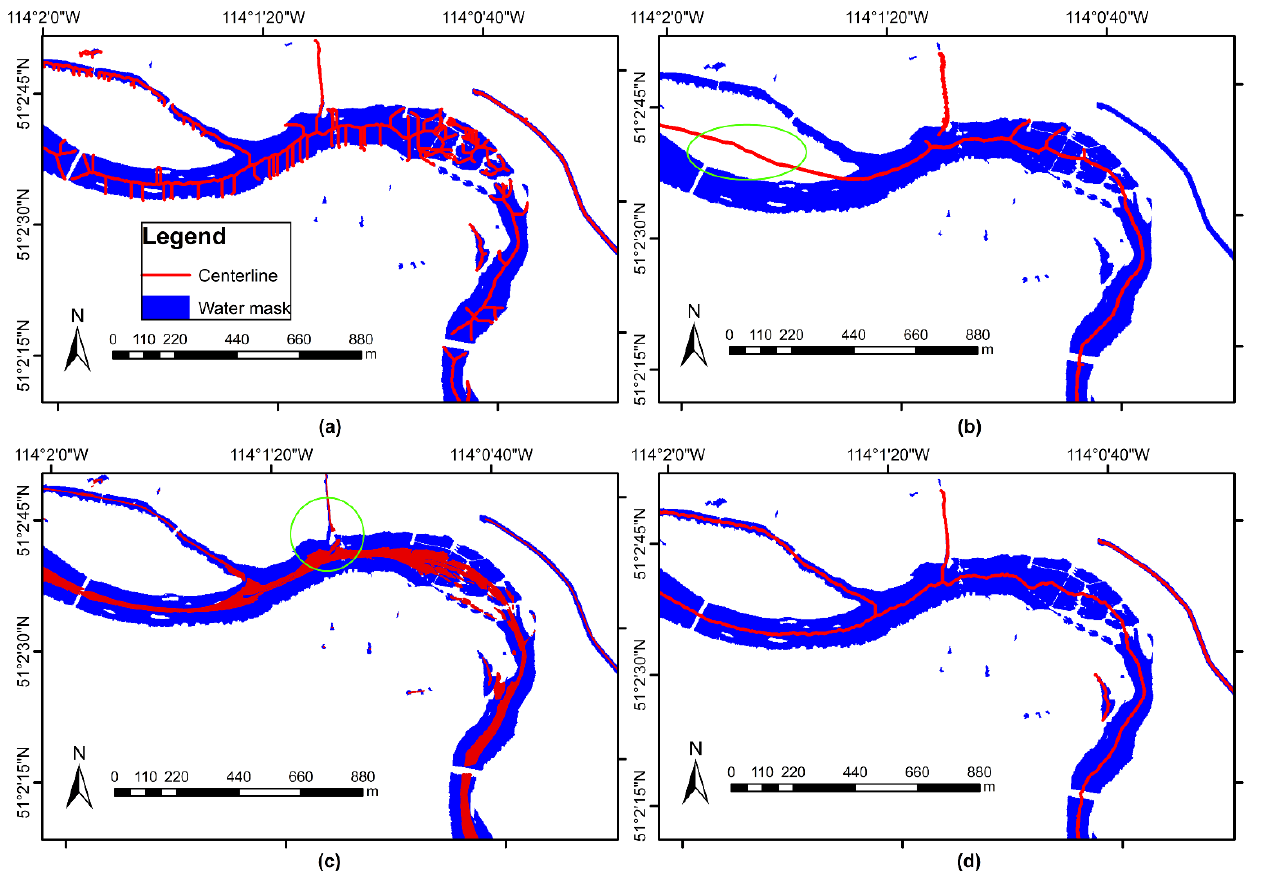
Figure 12. The comparison of river centerline extraction methods over a section of the Bow River site: ( a ) morphological method; ( b ) the RivWidth method described in [37]; ( c ) the Mean-shift method described in [36]; and ( d ) the proposed